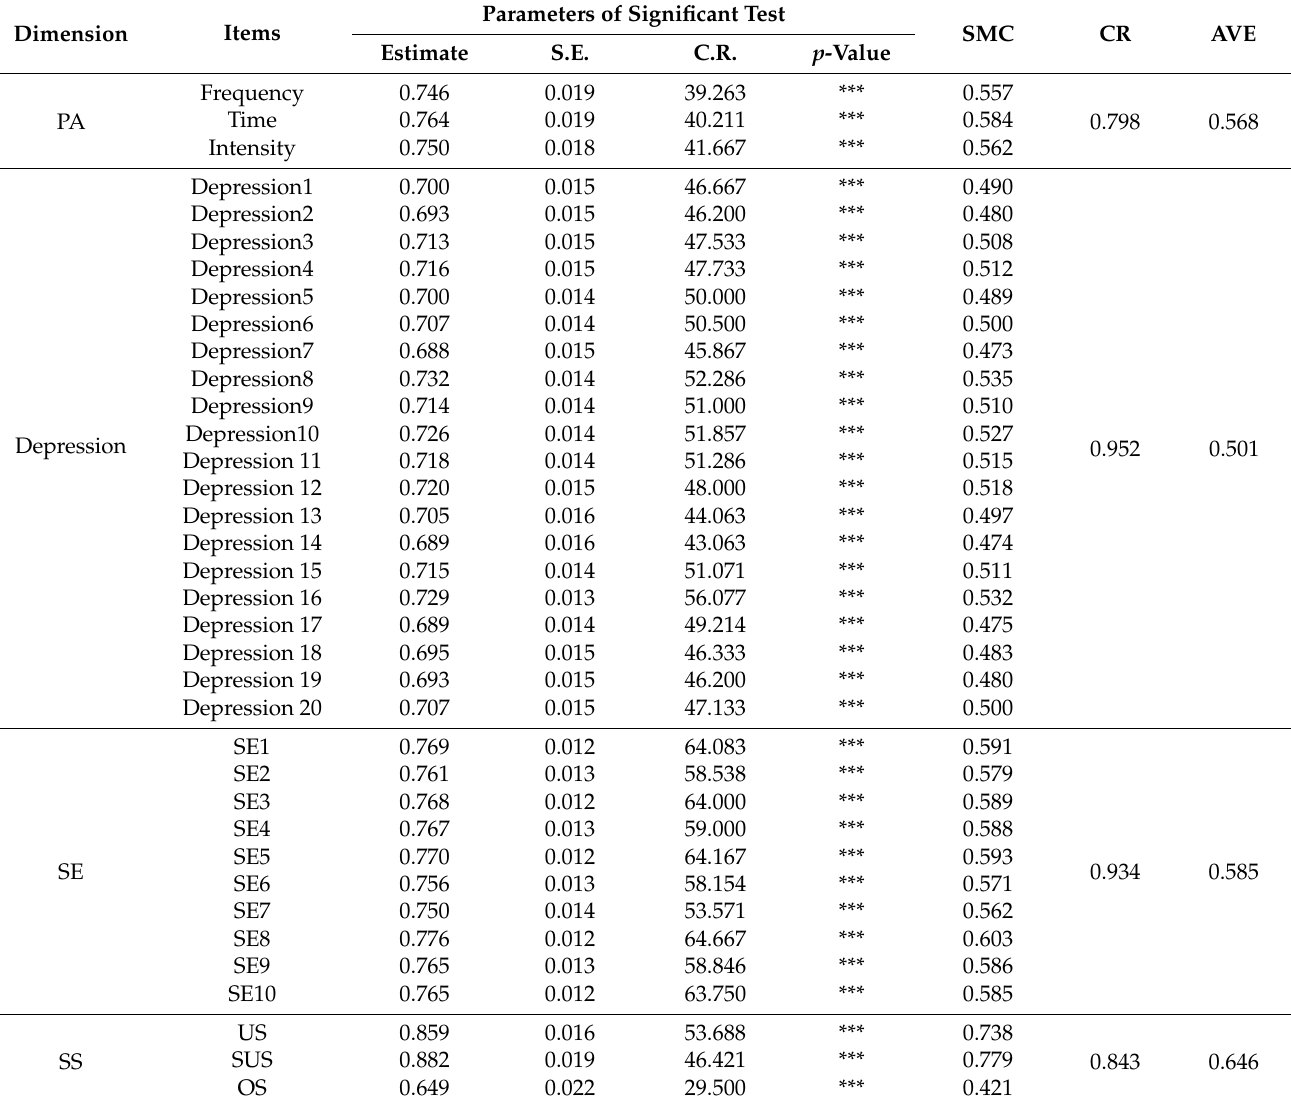
Table 2. Confirmatory factor